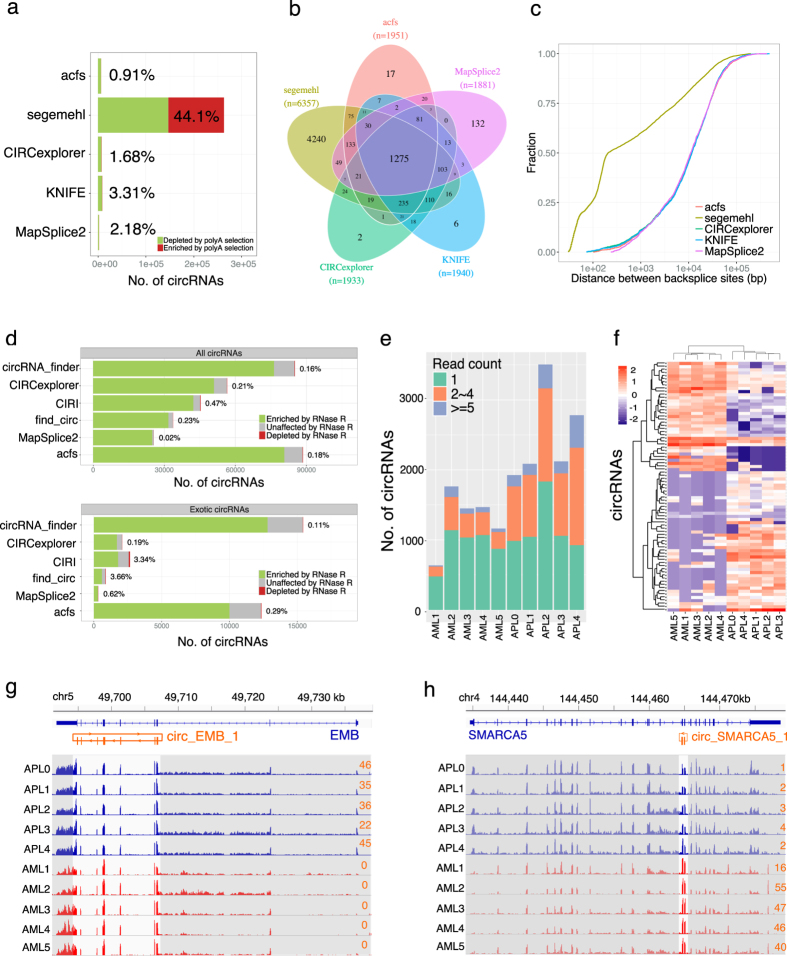
Application of acfs on real datasets suggests the high performance of acfs.(a) Barplot shows the number of circRNAs identified by acfs(6363), KNIFE(8774), CIRCexplorer(7254), segemehl(243004) and Mapsplice2(1923) in Dataset A, and acfs shows the smallest FDR. (b) Venn diagram of the overlap of circRNAs (> = 2 reads) among five circRNA prediction tools in Dataset A. (c) Cumulative distribution of the splice distance for circRNAs predicted in Dataset A. (d) Acfs identified more RNase R resistant circRNAs than five other tools on Dataset B with low FDR. (e) The number of circRNAs identified in the APL and CN-AML samples with different thresholds. (f) Heatmap of 80 differentially represented circRNAs between CN-AMP and APL samples. (g,h) Representative examples of circRNAs that are enriched in APL (g) and CN-AML (h). Light-colored regions highlight the read coverage in the circRNAs. The numbers (colored in orange) to the right of both panels (g,h) denote the number of reads supporting the BSJ in each sample.